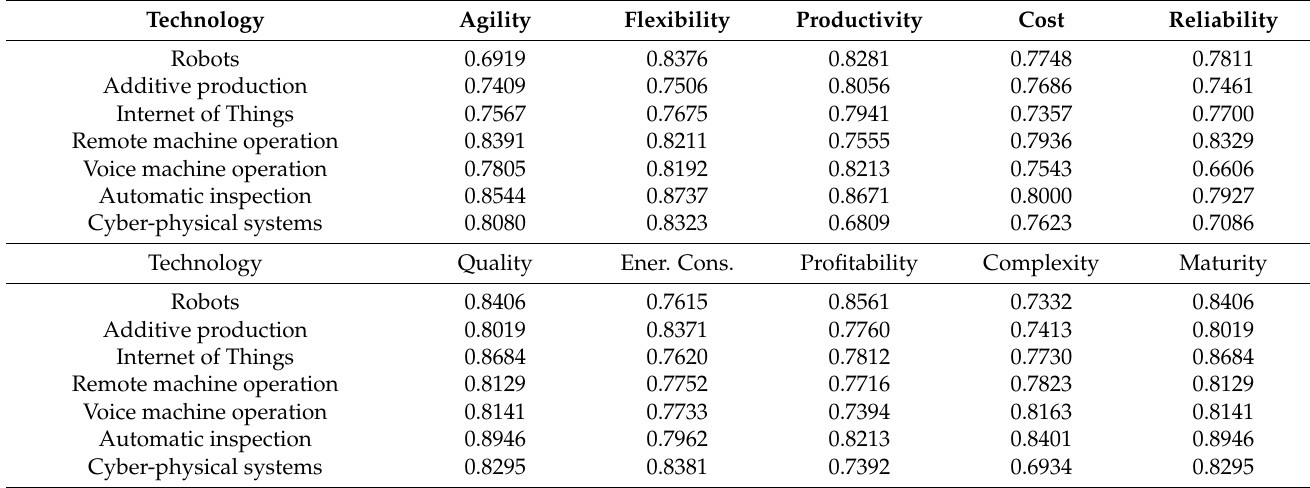
Table A12. The overall utility matrix of weighted geometric